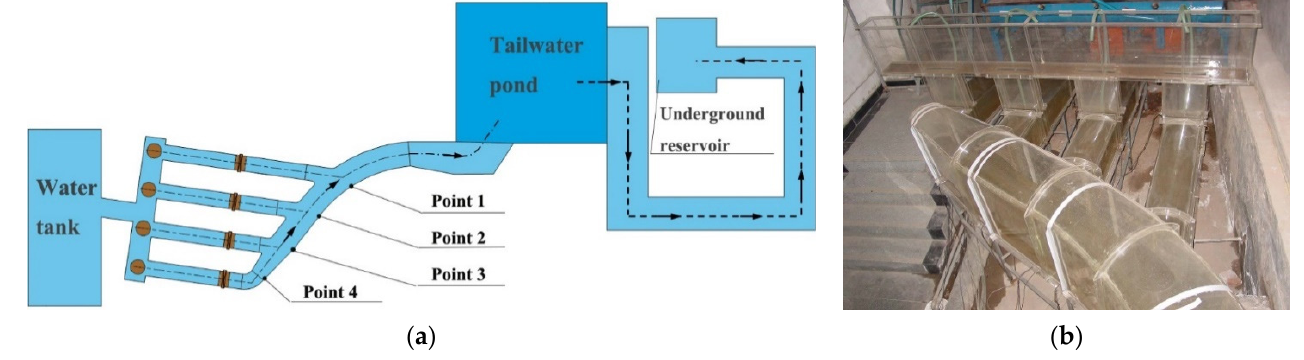
Figure 2. The diagram ( a ) and experimental rig ( b ) of the tailrace tunnel.